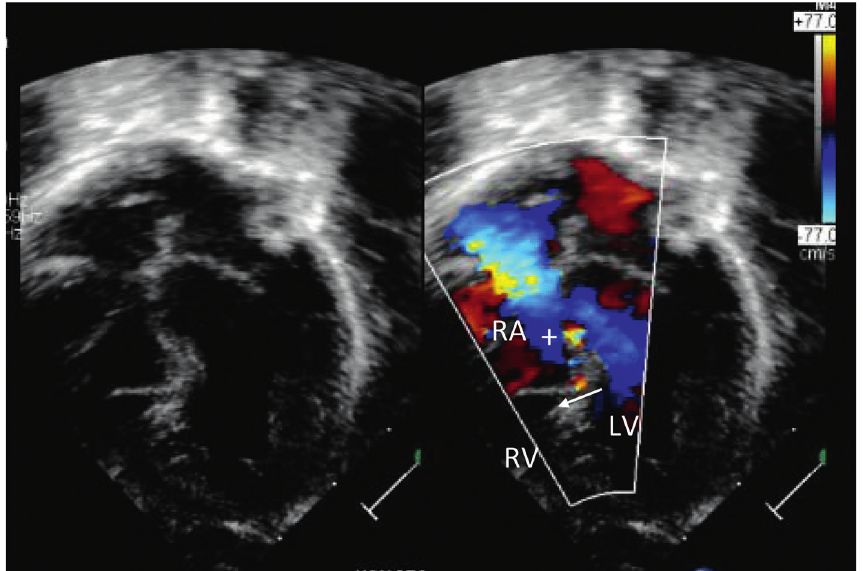
Figure 2: Transthoracic echocardiogram with 2D and color Doppler showing an apical displacement of septal leaflet of the tricuspid valve (arrow) and atrialization of RV. A left to right shunt is also seen across a VSD into the atrialized